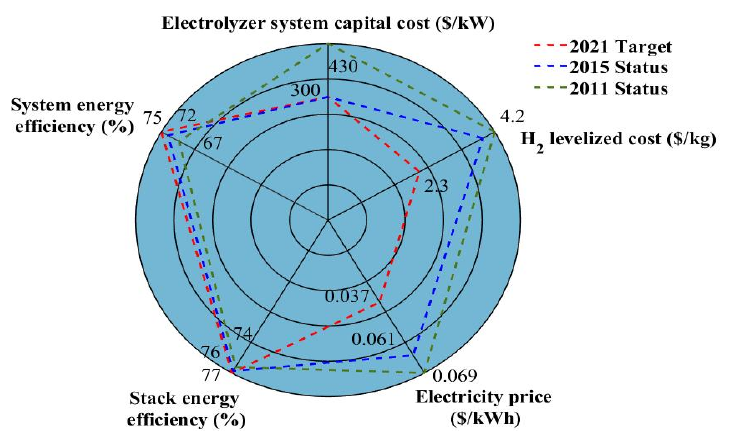
Figure 1. Radar diagram summarizing the status (2011 and 2015) and targets (2021) of hydrogen production by water electrolysis.